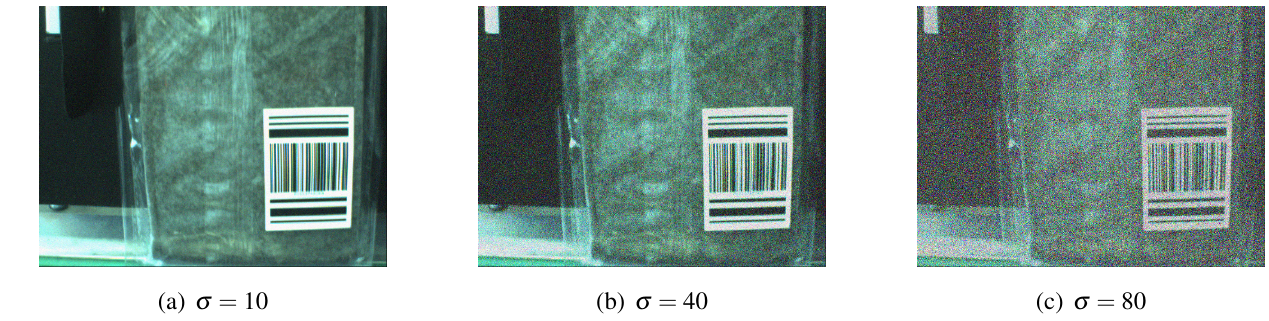
Figure 19. User-defined marker with Gaussian